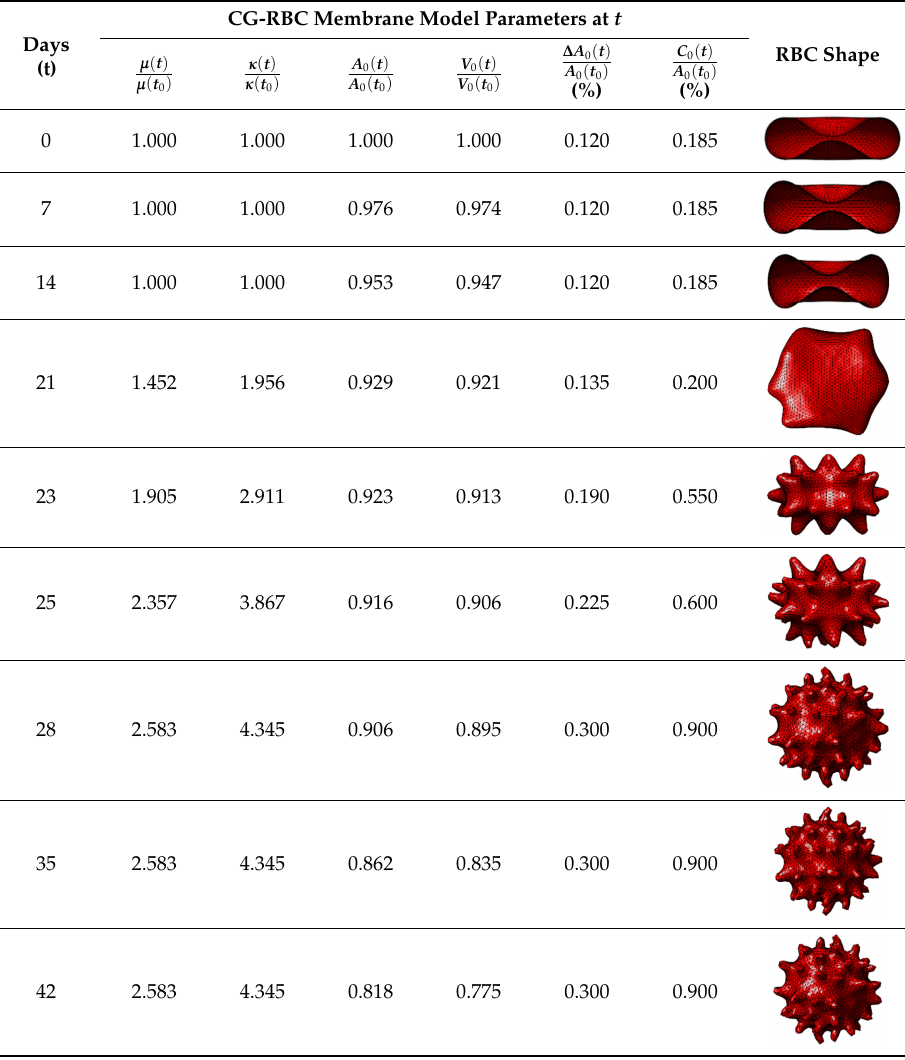
Table 1. The CG-RBC membrane model-predicted morphology of in-vitro stored RBC. Shear modulus ( µ ( t ) ), bending modulus ( κ ( t ) ), cell surface area ( A 0 ( t ) ) and cell volume ( V 0 ( t ) ) during in-vitro storage are presented in the form of multiplications of µ ( t 0 ) , κ ( t 0 ) , A 0 ( t 0 ) , V 0 ( t 0 ) , respectively, which represent the corresponding parameters at t = 0 (Days) (refer to Figures 2 and 3). ∆ A 0 ( t ) and C 0 ( t ) are the reference bilayer-leaflet-area-di ff erence and reference total-membrane-curvature, respectively (refer to Geekiyanage et al. [76]). Cross-sectional view of discocyte morphology is presented. CG-RBC Membrane Model Parameters at Days (t)